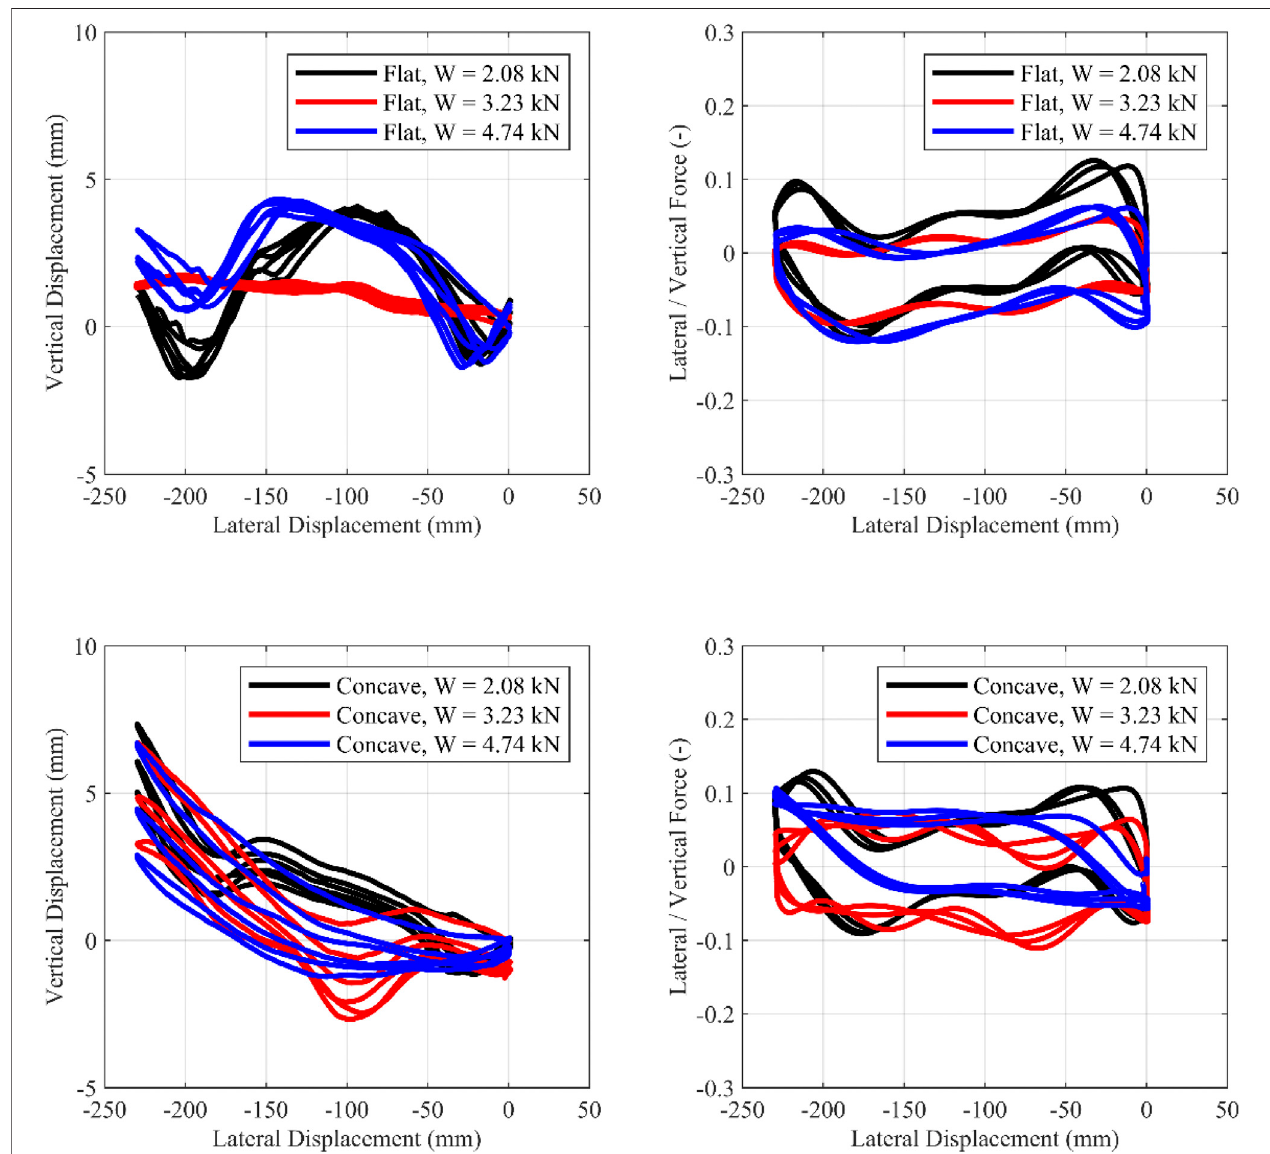
FIGURE 9 | Cyclic motion 0/ − 230 mm. In fl uence of the vertical load. Left , Vertical-horizontal displacement; Right , Lateral/Vertical force — Lateral displacement.